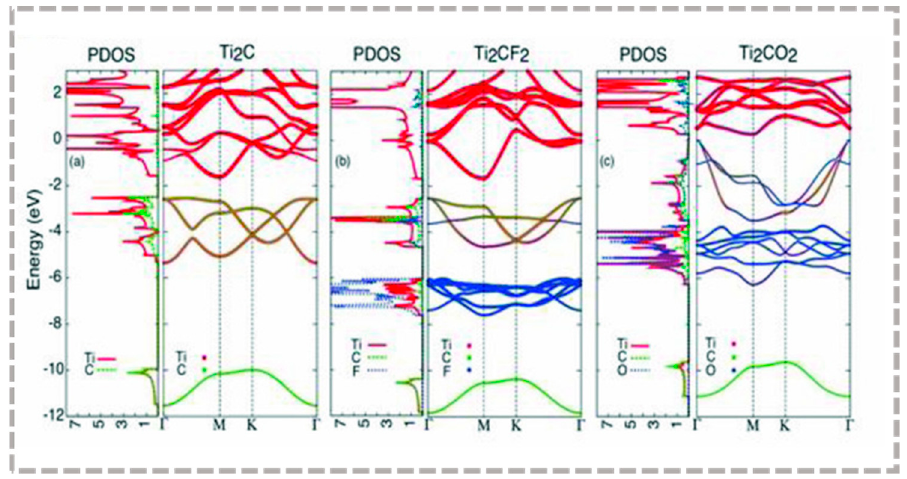
Figure 5. Band structure diagram of the -OH, -F terminations and bare Ti 2 C MXene monolayers, showing that MXene changes from metal to semiconductor due to changes in surface chemistry [70].